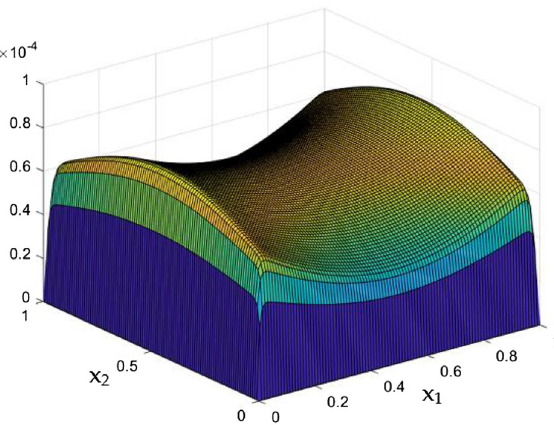
Figure 16. Velocity field for Ra = 100,000 and M = 60.